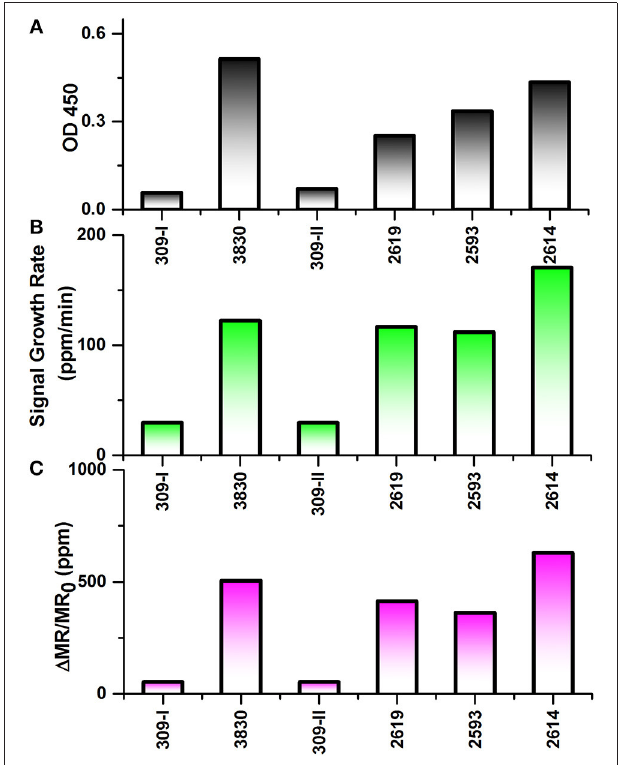
FIGURE 5 | Testing results of six nasal swab samples by ELISA and Z-lab measurement. The six samples are numbered as 309-I, 3,830, 309-II, 2,619, 2,593, 2,614. (A) Averaged signal from 100 µ L heat inactivated nasal swab samples tested by ELISA. (B) The signal growth rate in the first 4min of Z-lab measurement. (C) Averaged signal in the first 4min of Z-lab measurement. The error bars indicate the standard deviation of the signal from GMR sensors on the chip as well as from ELISA